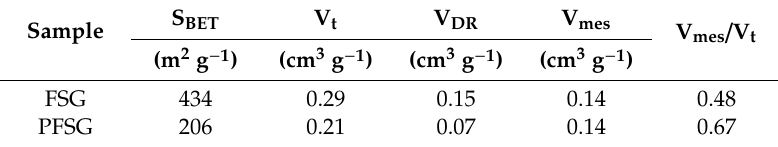
Table 1. Textural properties of the FSG and PFSG